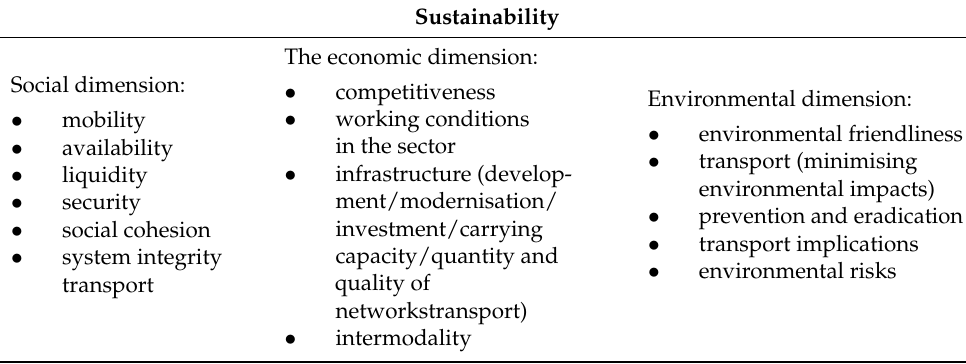
Table 1. Dimensions of sustainable transport